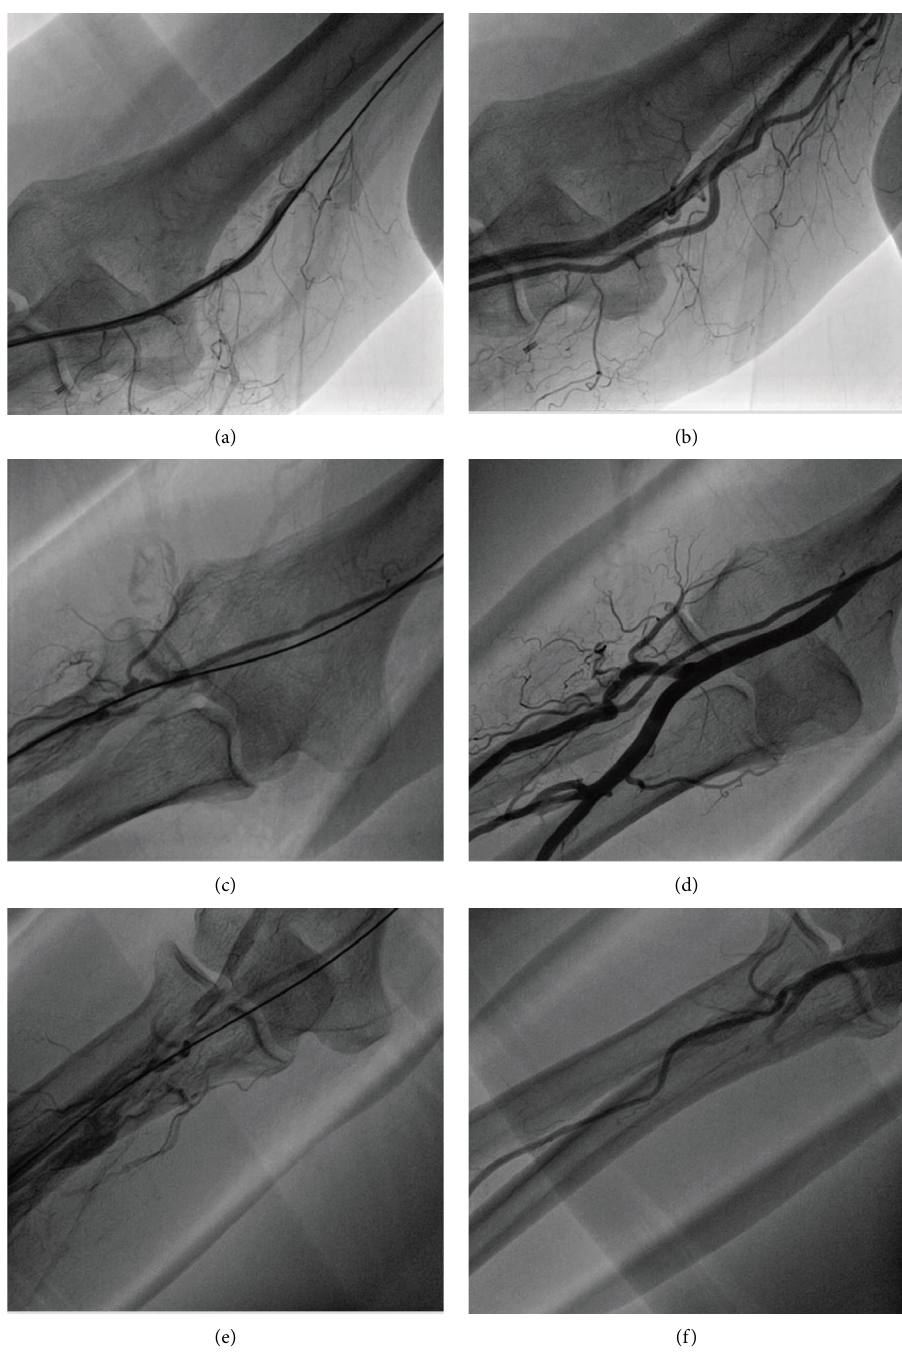
Figure 2: (a) Radial angiogram demonstrating occlusive radial spasm. (b) Radial angiogram following completion of the procedure with a sheathless Eaucath guiding catheter (SEGC) demonstrating a high origin of the radial artery with resolution of previous spasm. (c) Radial angiogram demonstrating tortuosity and severe spasm of the radial artery. (d) Radial angiogram following completion of the procedure with a SEGC demonstrating moderate tortuosity with resolution of previous radial spasm. (e) Radial angiogram demonstrating radial spasm and perforation. (f) Radial angiogram following completion of the procedure with a SEGC demonstrating resolution of the radial spasm and